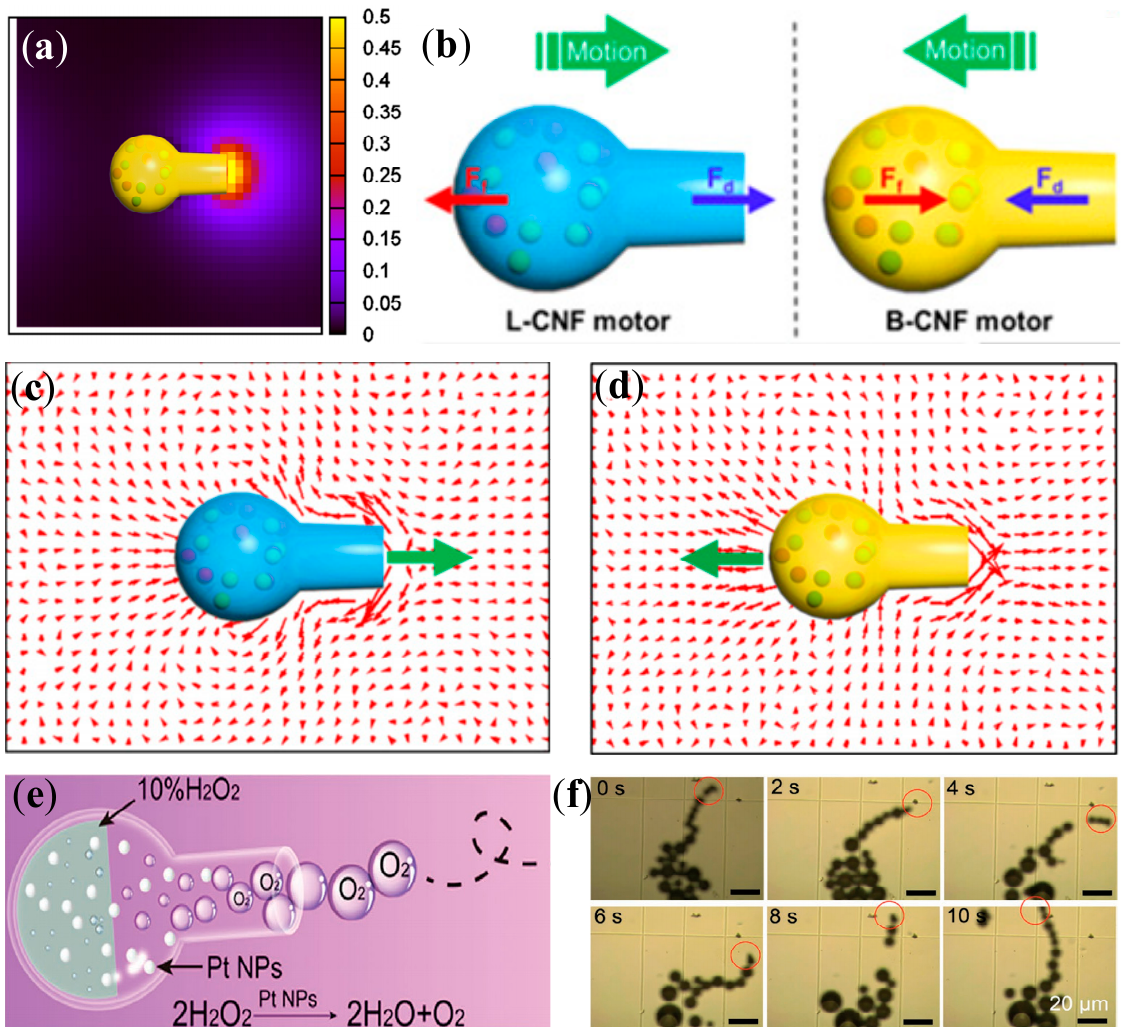
Figure 2. ( a ) The concentration distribution of products caused by catalytic reaction. ( b ) The driving force ( F d ) and friction ( F f ) of hydrophilic carbonaceous nanobottle motor and hydrophobic car- bonaceous nanobottle motor exerted by the chemical gradient. ( c ) Puller-like flow field around the hydrophilic carbonaceous nanobottle motor. ( d ) Pusher-like field around the hydrophobic carbona- ceous nanobottle motor, where the red arrow represent the flow velocity and green arrow express motion direction. Reprinted with permission from Ref. [35]. Copyright 2019, copyright American Chemical Society. ( e ) Bubble generation inside the SiO 2 nanobottle motor. ( f ) Photos of